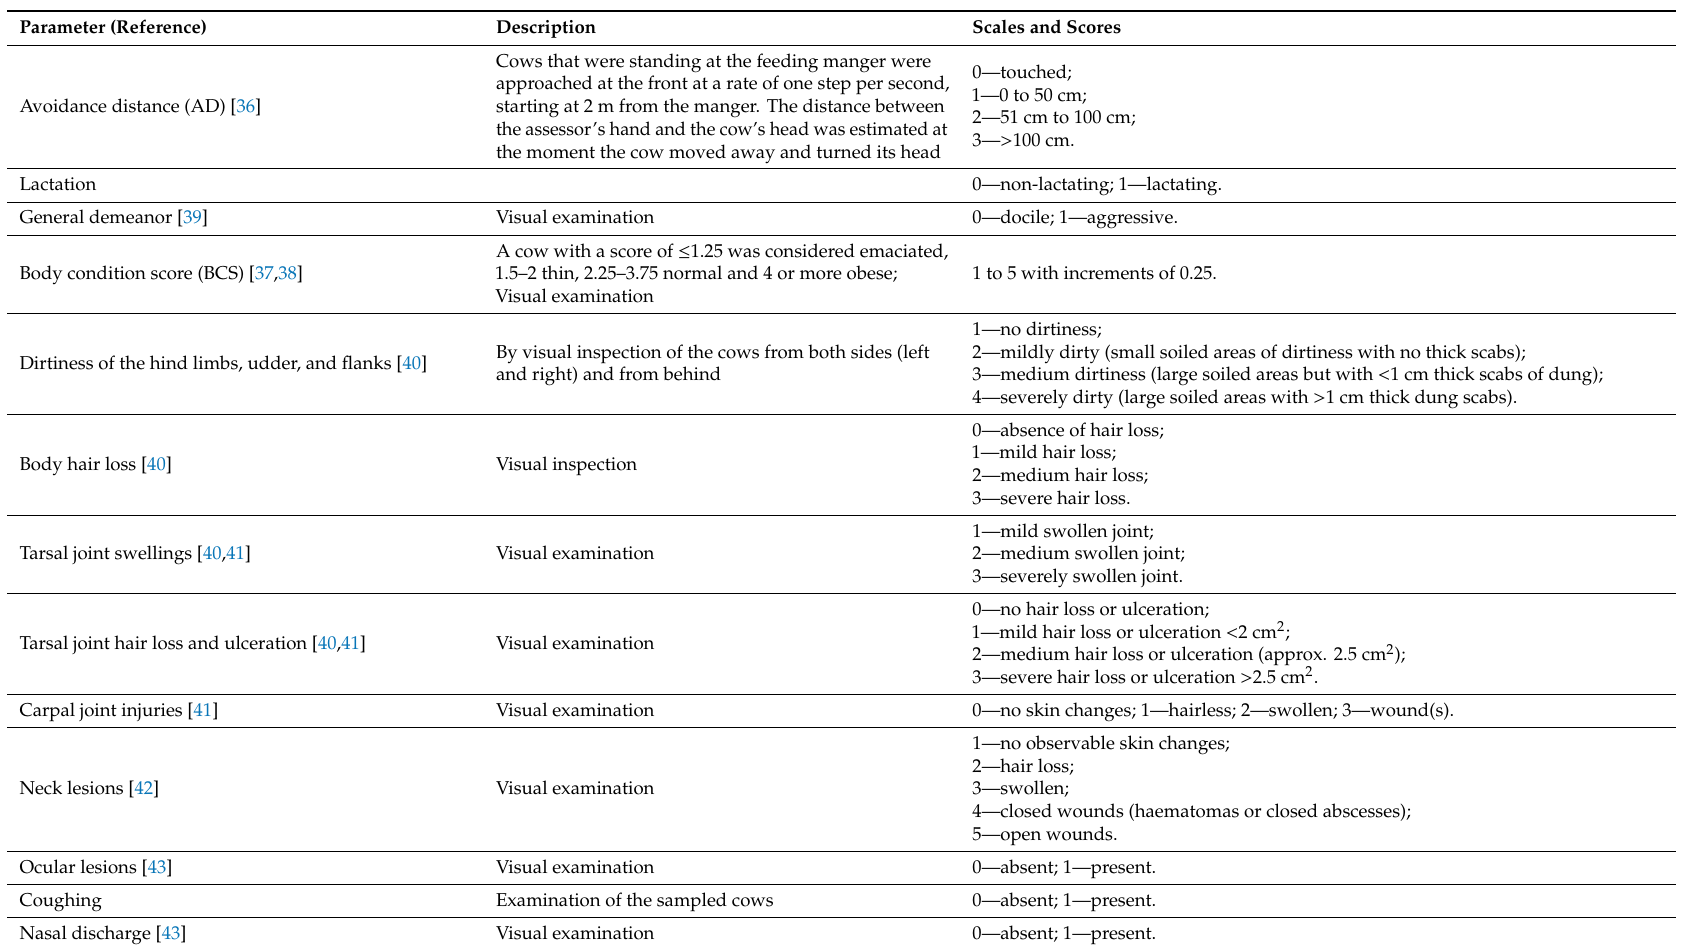
Table A1. Description of various cow-based welfare